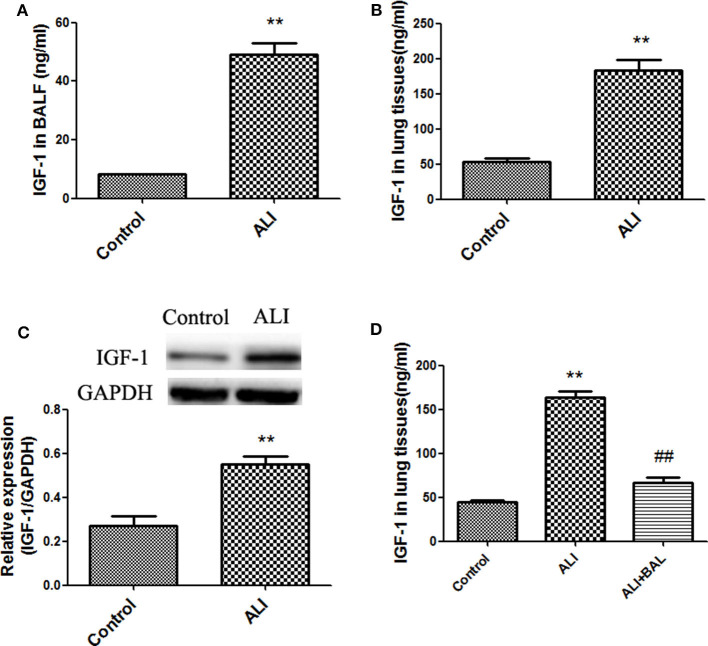
Increased IGF-1 production in acute LPS lung injury models. (A–D) BALB/c mice were instilled with LPS (4 mg/kg) into the nasal cavity to develop an ALI model. After 24 h of LPS instillation, IGF-1 content was detected in BALF (A) and lung tissue homogenates (B), and the expression of the IGF-1 protein in lung tissues (C) was detected by immunoblotting. **P < 0.01 vs. control group. (D) After ALI model mice were subjected to BAL (ALI + BAL), lung tissues were collected for homogenization, and the IGF-1 content in the homogenate was detected by ELISA. **P < 0.01 vs. the control group, ##P < 0.01 vs. the ALI group.